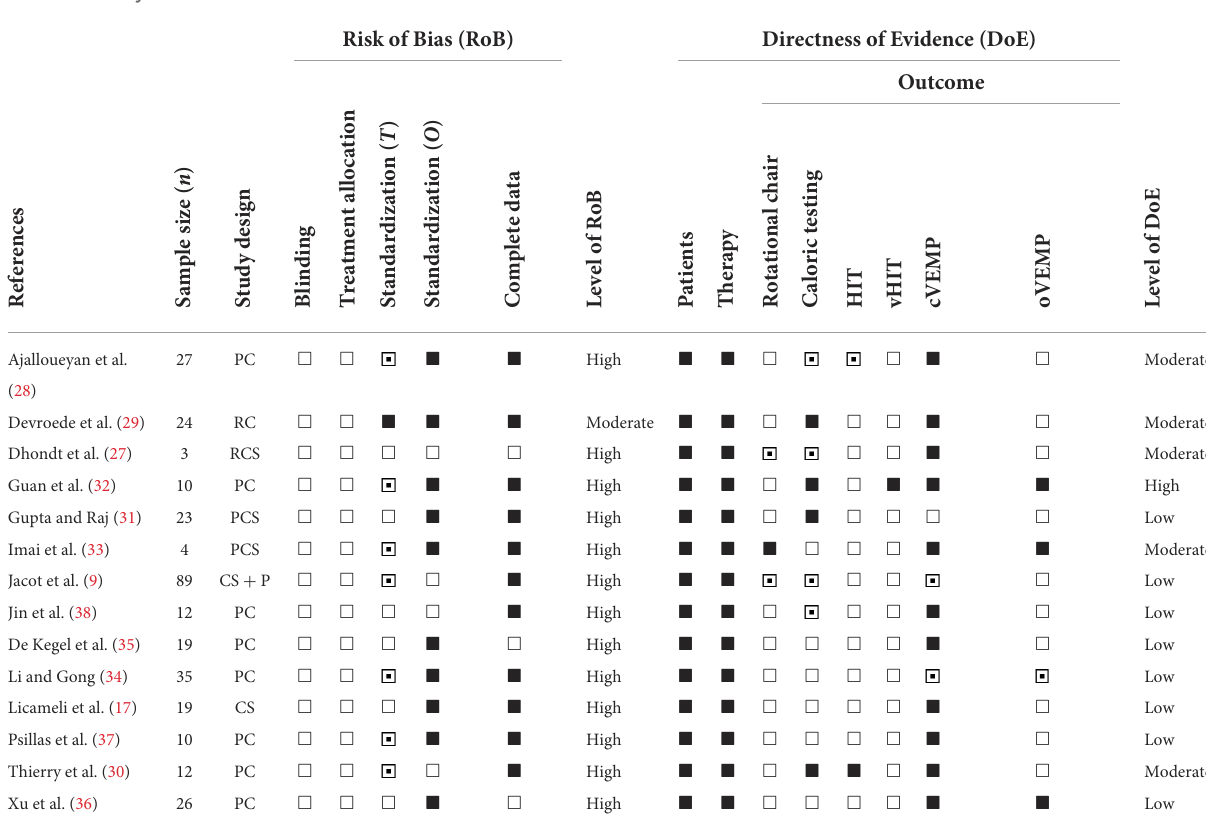
TABLE 3 Quality assessment of included